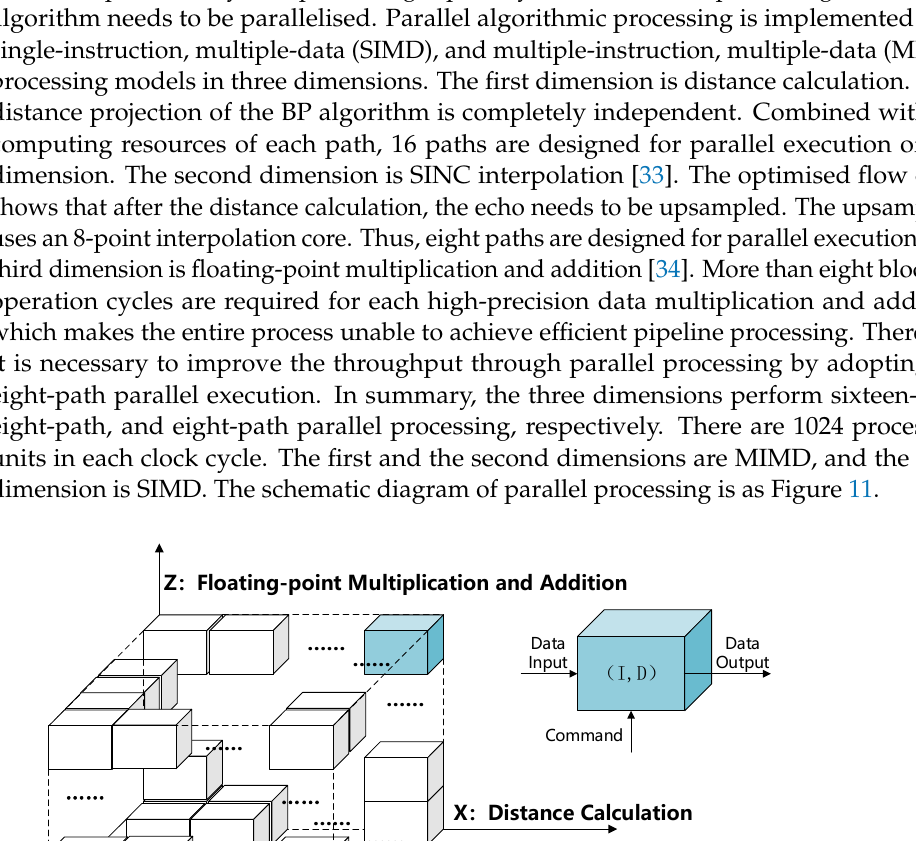
Figure 10. Bit-width design in the processing flow.